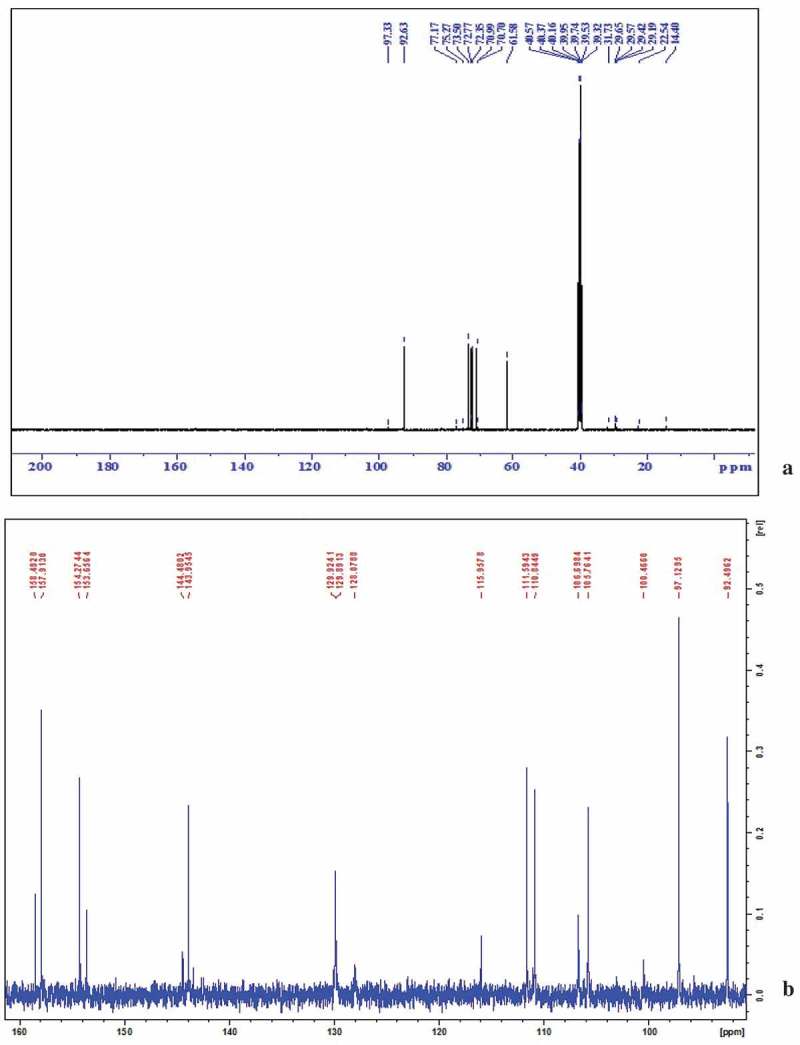
13C NMR spectra of compound I (ascotricin A).